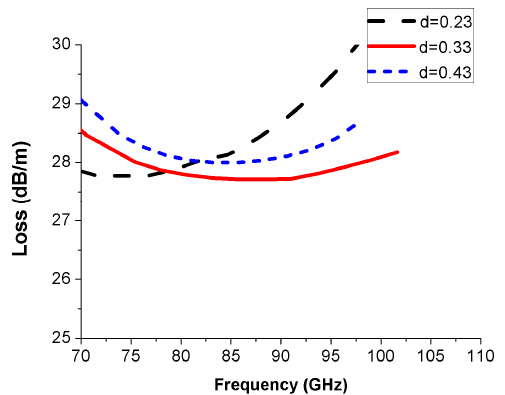
Figure 6. Loss of the CV-FWG for various values of Ac.